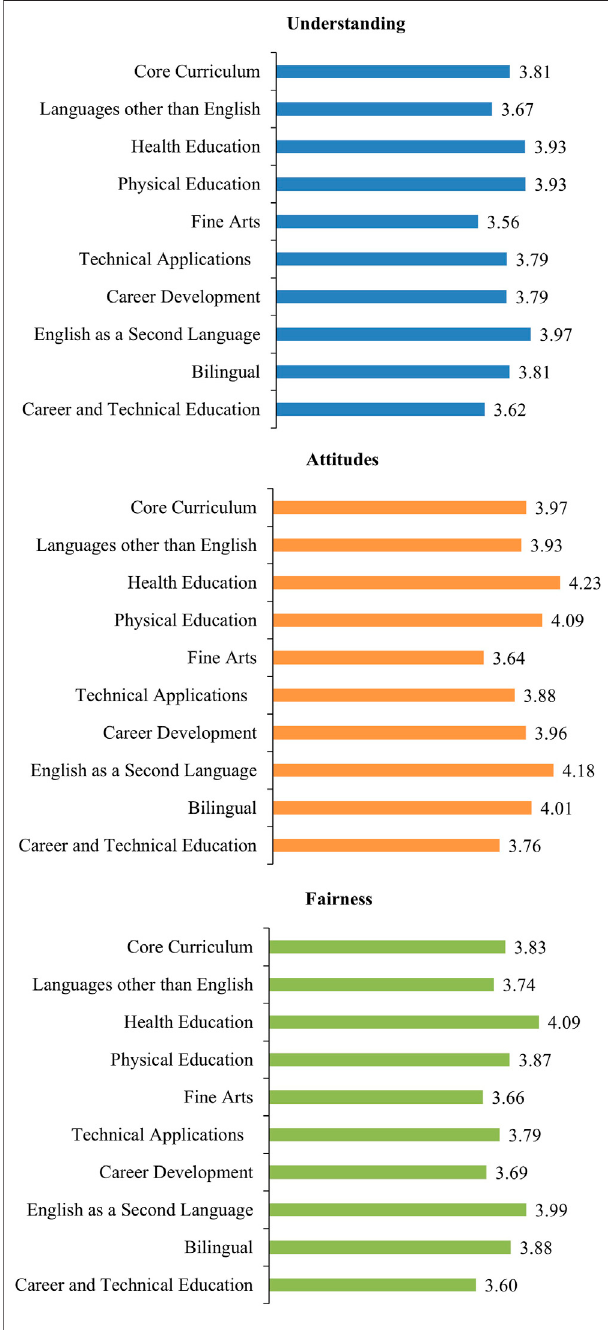
FIGURE 3 | Mean scale scores by teaching